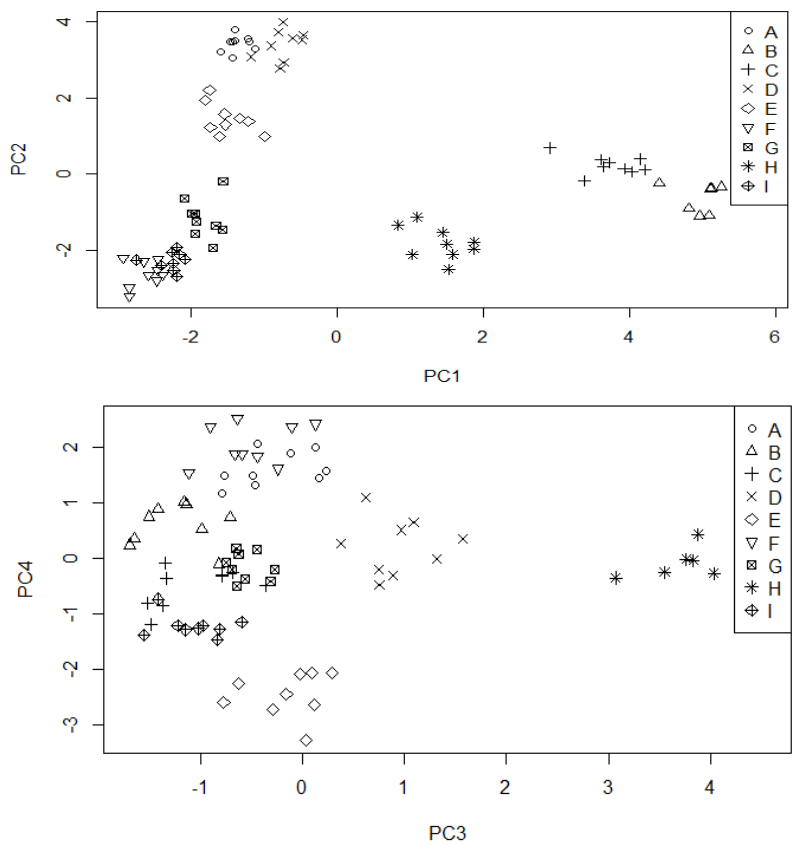
Figure 2. Principal Component Analysis Scores for tea dataset. A — CH (China, original); B — CH1 (China, blended); C — I (India); D — SL (Sri Lanka); E — N (Nepal); F — SKJ (Jeoncha, South Korea); G — JA (Agari, Japan); H — JM (Matcha, Japan); I — JS (Sencha, Japan).